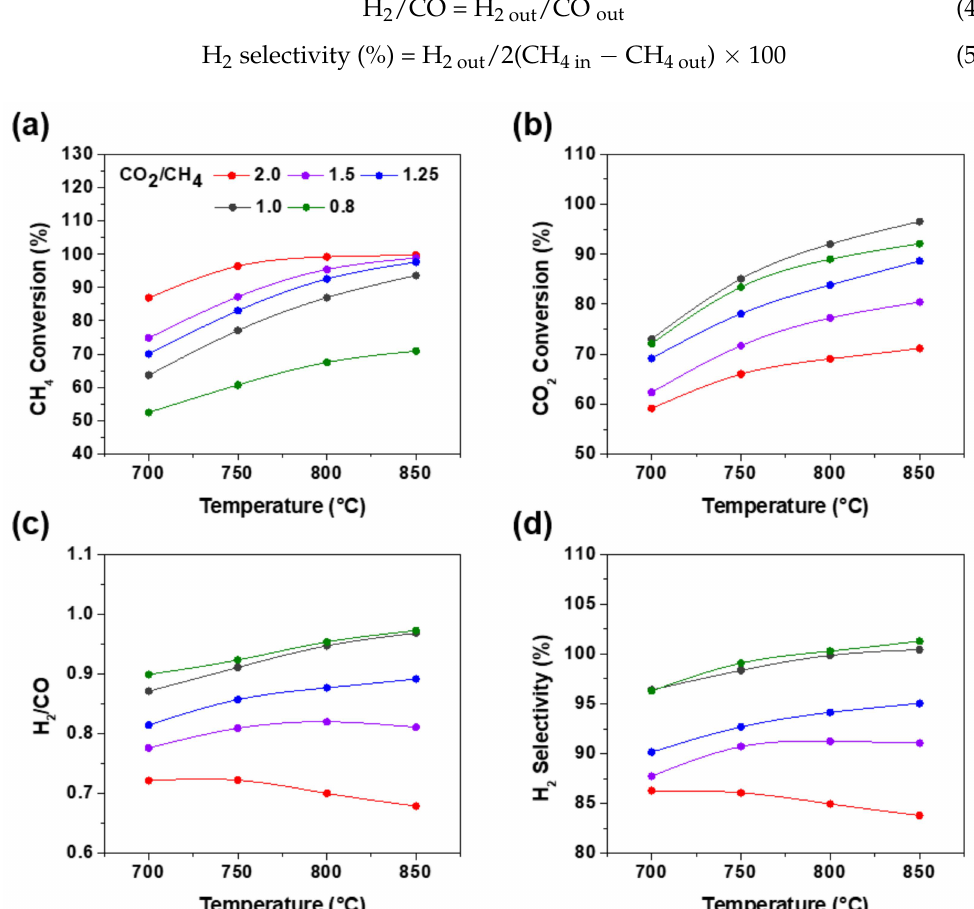
Figure 2. Influences of reaction temperature (700, 750, 800 and 850 ◦ C) on ( a ) CH 4 conversion, ( b ) CO 2 conversion, ( c ) H 2 /CO, ( d ) H 2 selectivity; N 2 = 20 mL · min − 1 , WHSV = 60 L/g · h − 1